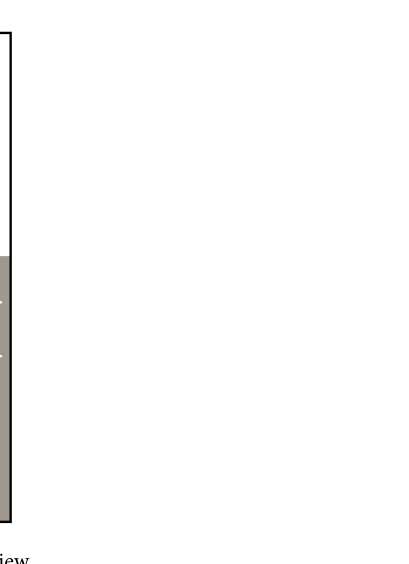
Figure 10. Illustrator images of 4 main zones in cross-section